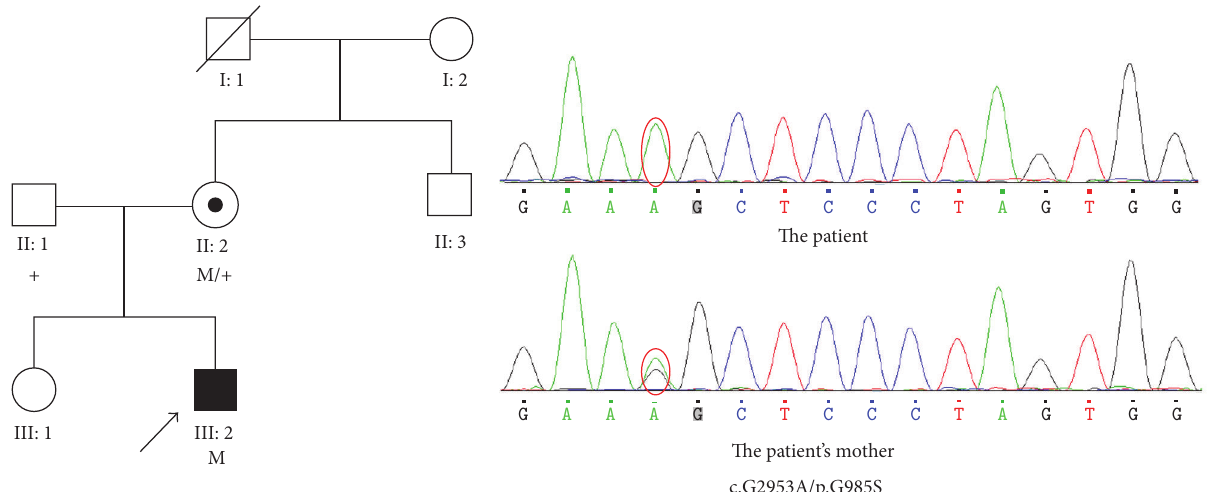
Figure 5: The sequence map, pedigree, and cosegregation analysis of the family with novel mutation of OFD1 .